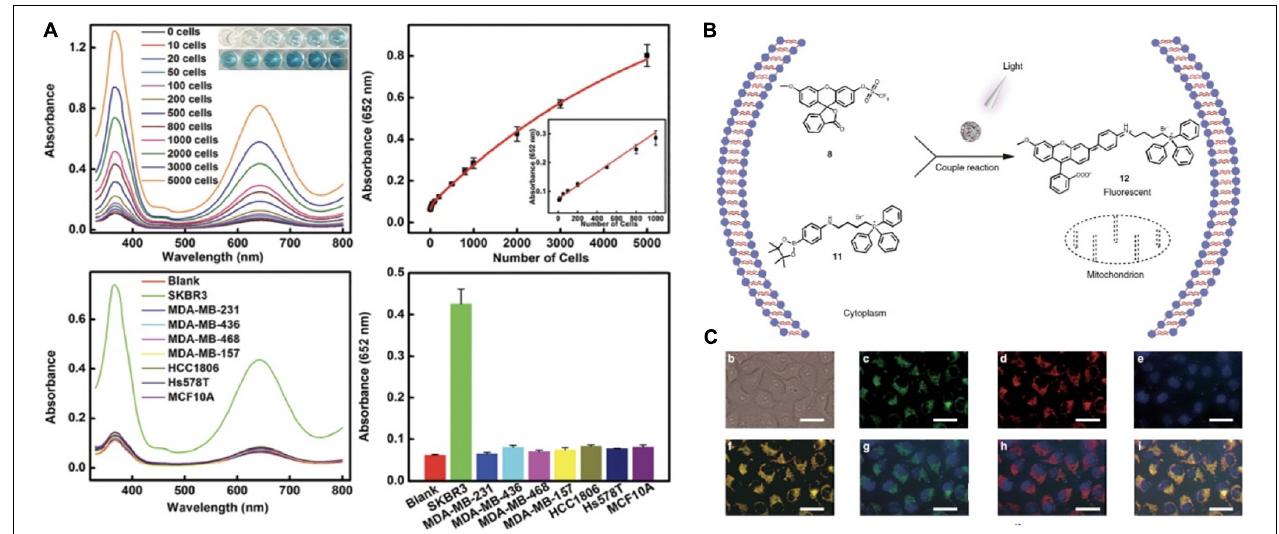
FIGURE 2 | Nanozymes for live cell and organelle imaging. (A) A multifunctional mesoporous silica-gold nanozyme platform for selective breast cancer cell detection using a catalytic amplification-based colorimetric assay. Reproduced with permission from ref (Li et al., 2019), © 2019, The Royal Society of Chemistry. (B) Scheme of nanozyme-based methods for mitochondrial fluorescent imaging. (C) Representative nanozyme-based light-mediated reversible catalysis for mitochondrial imaging. Adapted with permission from ref (Wang et al.,